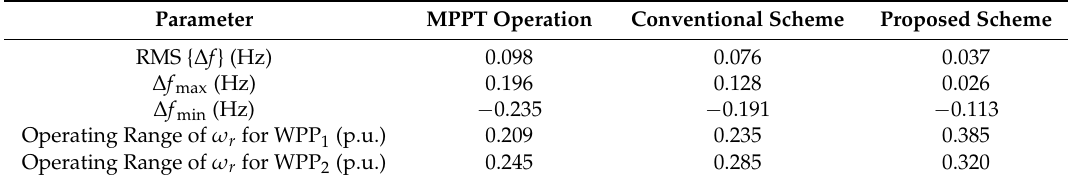
Table 2. Results for Case 2.